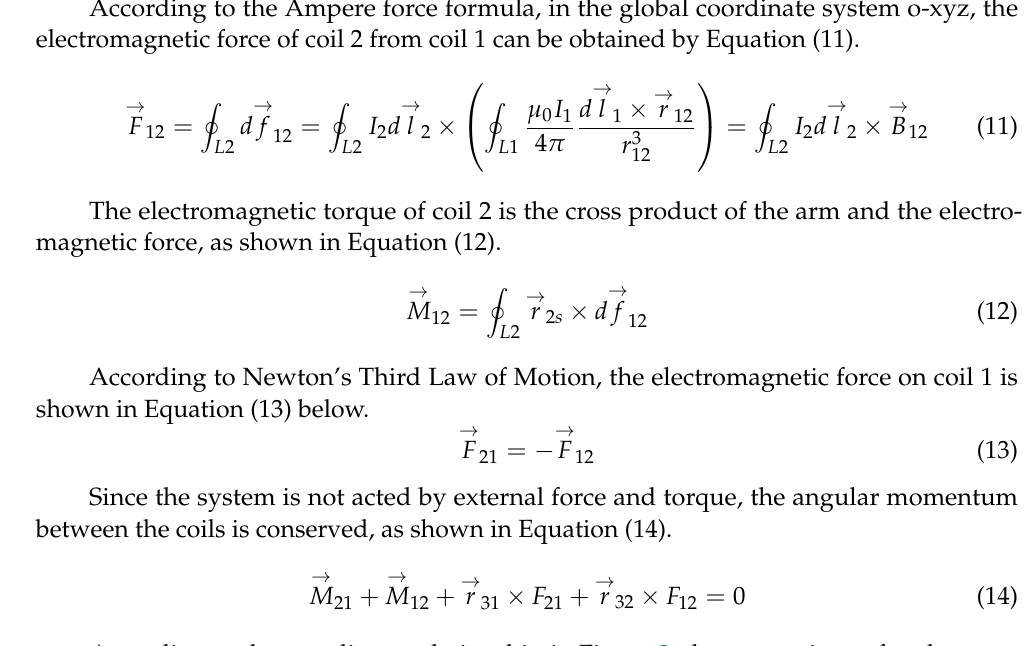
According to the coordinate relationship in Figure 2, the expressions of each vector are substituted into Equations (8)–(12). The high-order terms in the integral formula are omitted, and the far-field model of the electromagnetic force and torque can be obtained on the coils, as shown in Equations